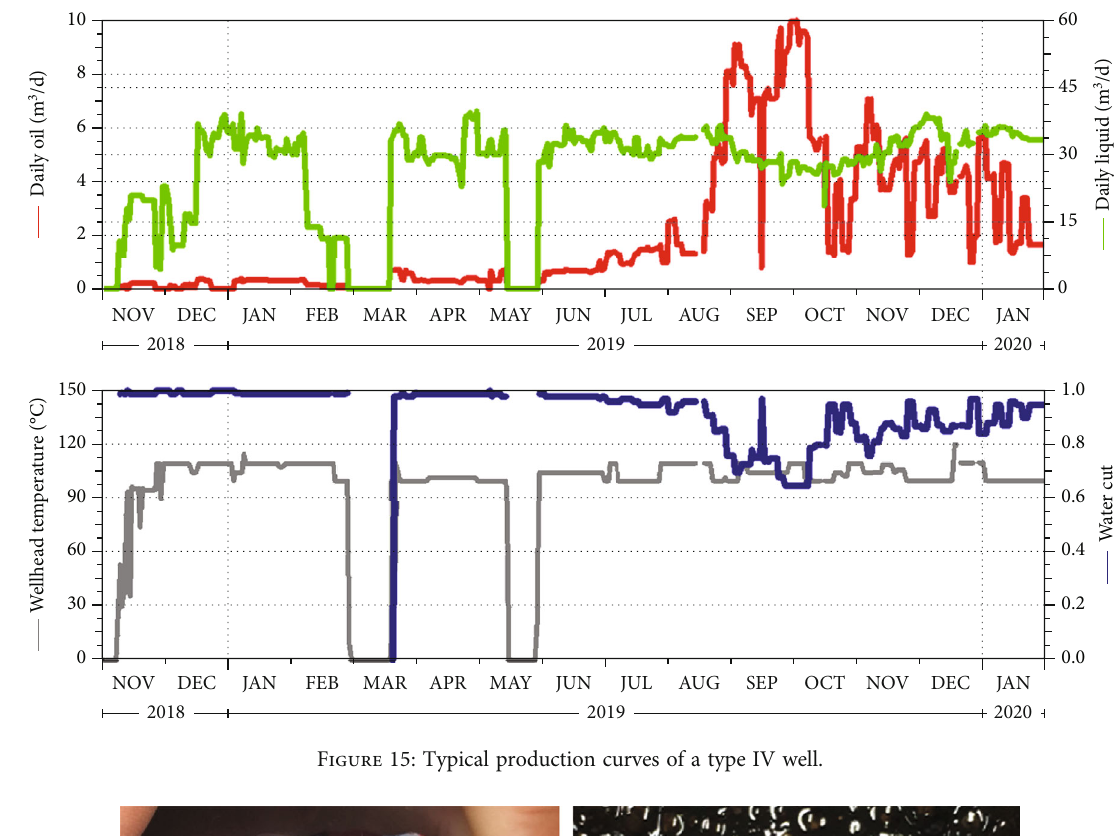
Figure 15: Typical production curves of a type IV well.